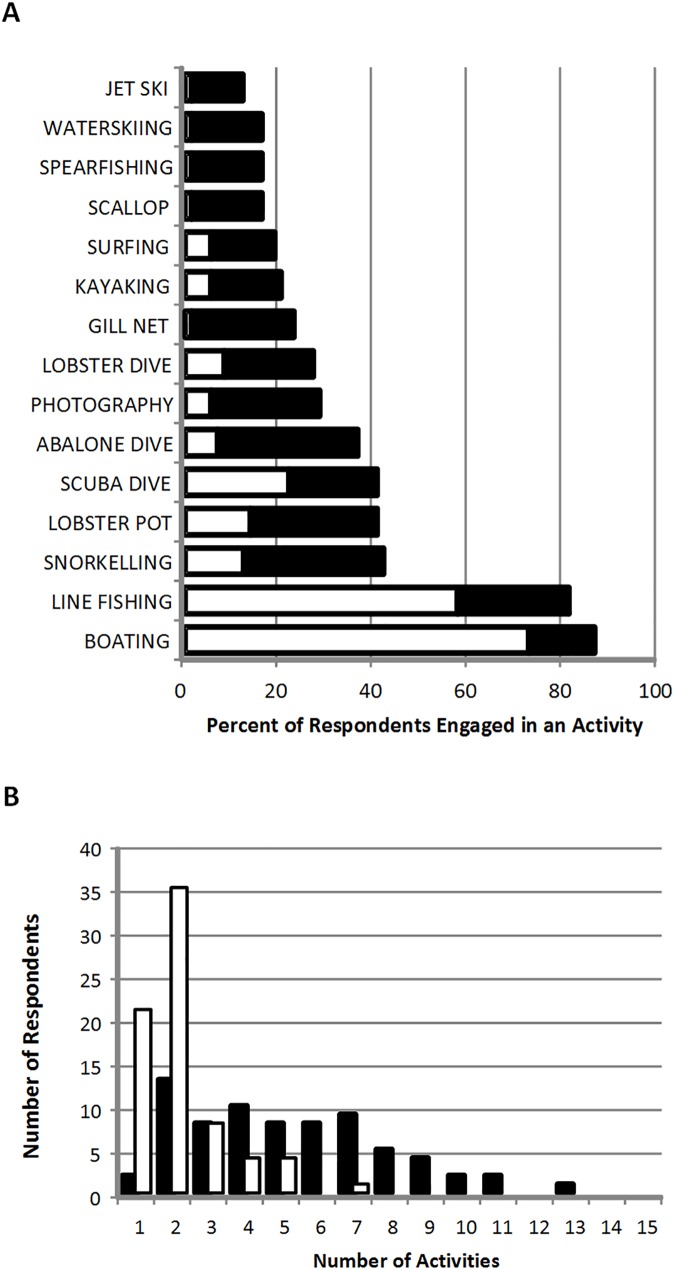
Survey respondents’ participation in marine activities A) on the day of survey and in general, and B) the number of cumulative activities for individual respondents. Black bars represent general participation in an activity and white bars represent participating in that activity on the day approached. Note that marine activities are not mutually exclusive for a respondent.